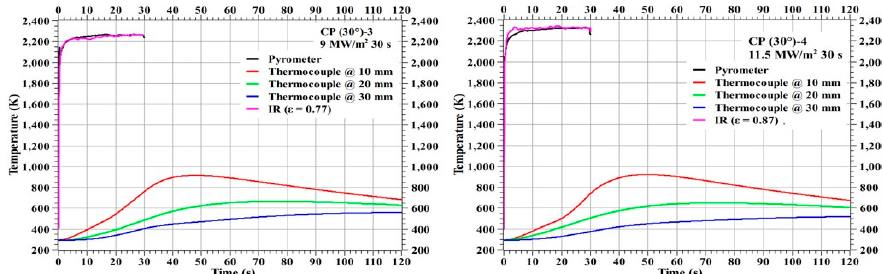
Figure 12. CP (30°)-3 and CP (30°)-4 temperature responses.